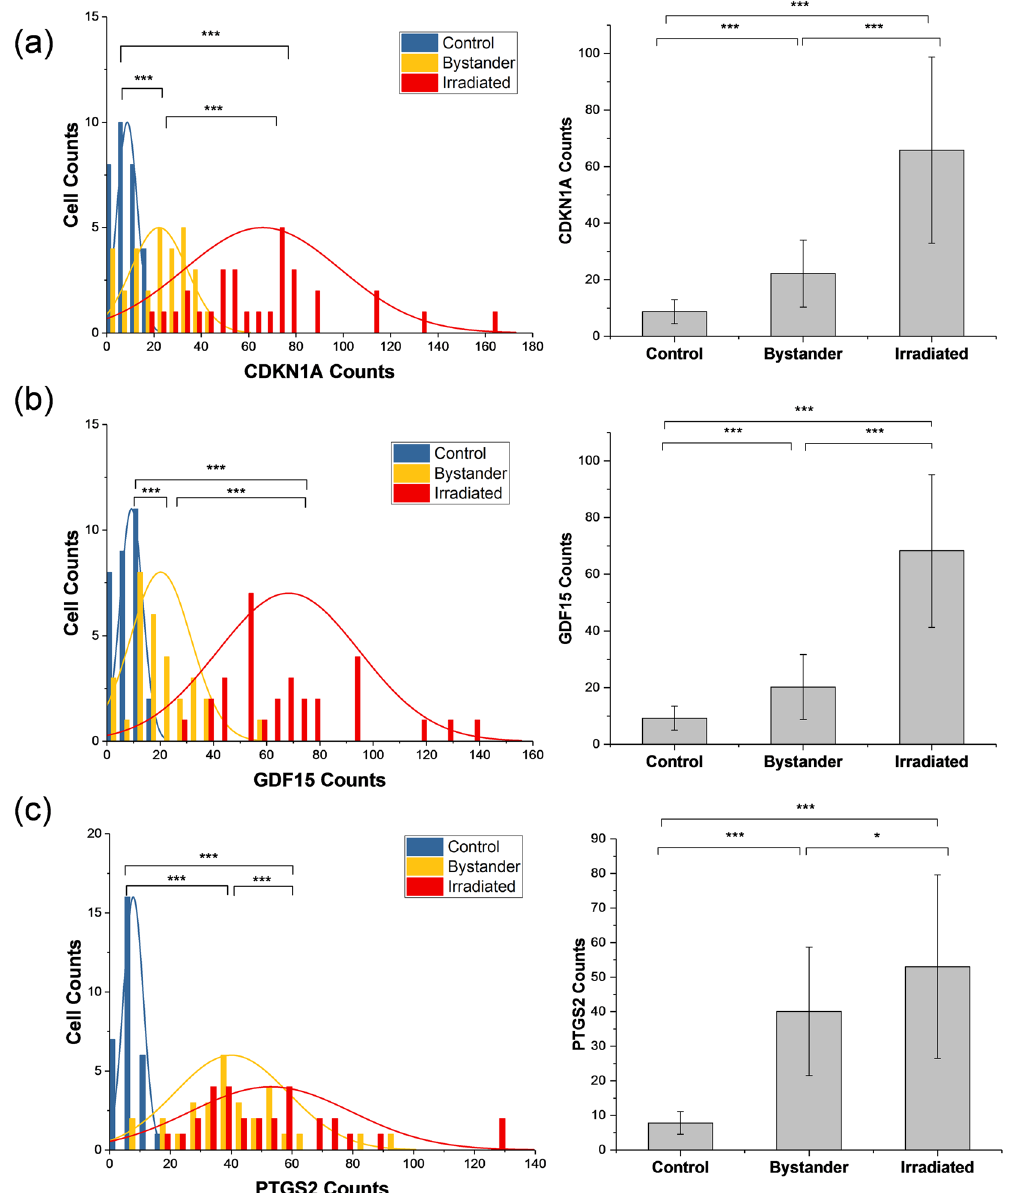
Figure 4. Left column: Significantly different distributions of transcript numbers of CDKN1A , PTGS2 and GDF15 as measured by digital PCR from individual control, bystander and microbeam-irradiated IMR90 cells. Right column: Comparisons of mean quantities of three gene products: CDKN1A , PTGS2 and GDF15 averaged over 30 individual control, bystander and microbeam-irradiated IMR90 cells. One asterisk ( * ) indicates p < 0.05 and three asterisks ( *** ) indicate p <